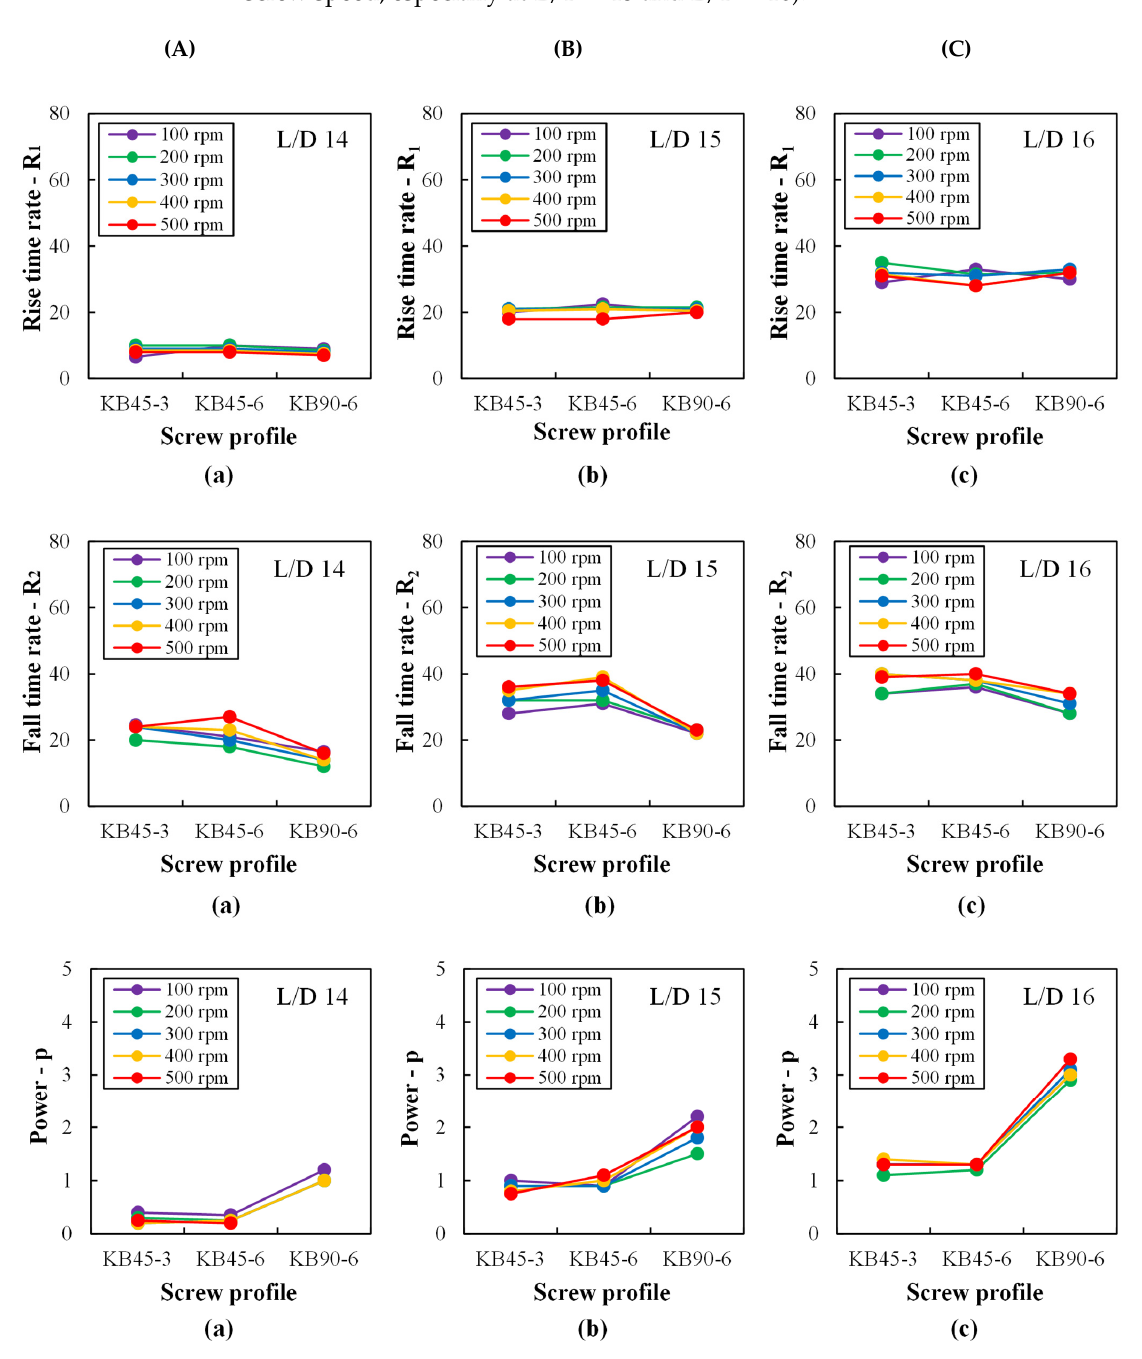
Figure 8. Rise ( R 1 ) and fall ( R 2 ) time rates and power exponent (p) parameters of the fitted pulse curve to the RTD curves measured with the barrel set to 230 °C along the mixing zone at ports: ( a ) L/D = 14, ( b ) L/D = 15, and ( c ) L/D = 16 for different kneading blocks ( A : KB45-3, B : KB45-6, and C : KB90-6) and various screw speeds (100 to 500 rpm).